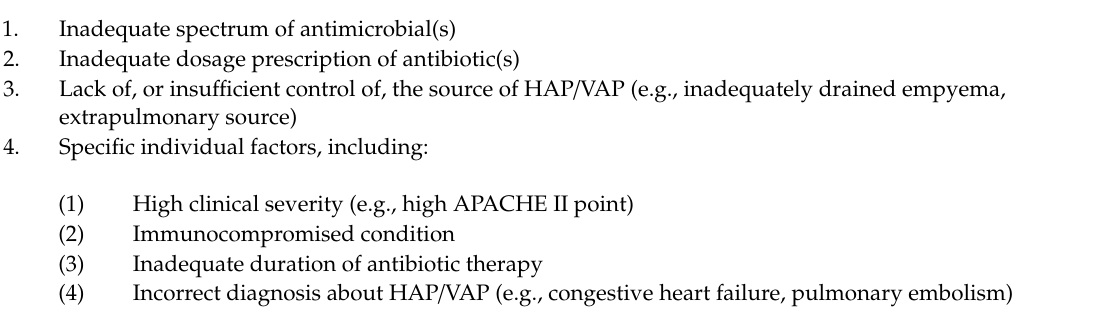
Table 4. Possible causes of failure of responding to initial antibiotic therapy against hospital-acquired and / or ventilator-associated pneumonia.